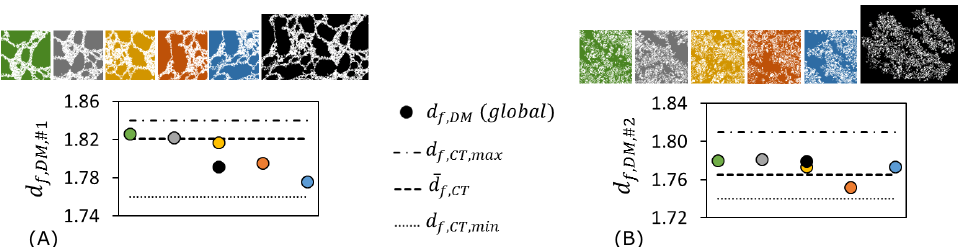
Figure 5. Self-similarity and comparison with CT, optical data at X50 magnification: ( A ) Specimen #1, ( B ) Specimen #2. Fractal dimension through the example cross-section is obtained from optical microscopy image: this shows simultaneously the self-similarity and the variation of fractality around a mean value for data obtained from optical digital microscopy. Tomography data is adapted from previously reported results by CT/HRCT [8] on same types of specimens. Subscripts: #1 is for epoxy-based specimen, #2 is for silicone-based specimen, CT is for computed tomography, DM is for optical/digital